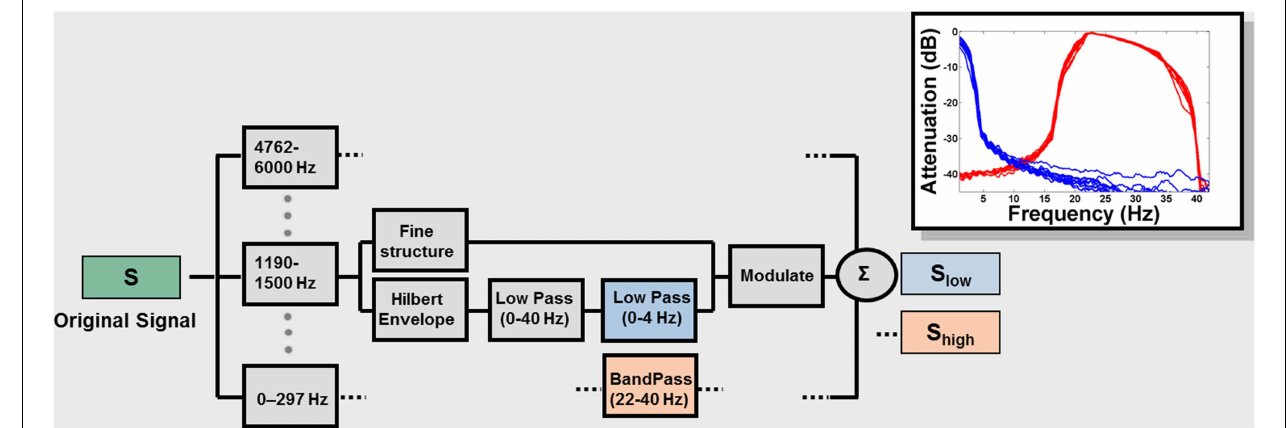
band- (22–40Hz) pass filtered (red blocks). The time delays, relative to the original signal, introduced by the filtering, were compensated by shifting the filter outputs. After the filtering, the envelope was combined with the carrier signal (fine structure) by multiplying the original band by the ratio between the filtered and original envelopes. The result for each original signal (S) is S low and S high , containing only low or high modulation frequencies. The inset shows the effect of the signal processing on a sample sentence. The attenuation caused by the filtering is plotted as a function of the frequency content of the envelopes. Blue: envelopes (for each of the 14 frequency bands) of S low ; Red: envelopes of S high